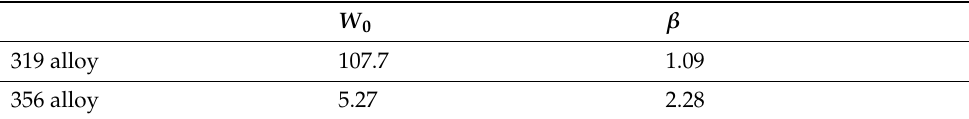
Table 7. Material parameters calculated with energy-based model.